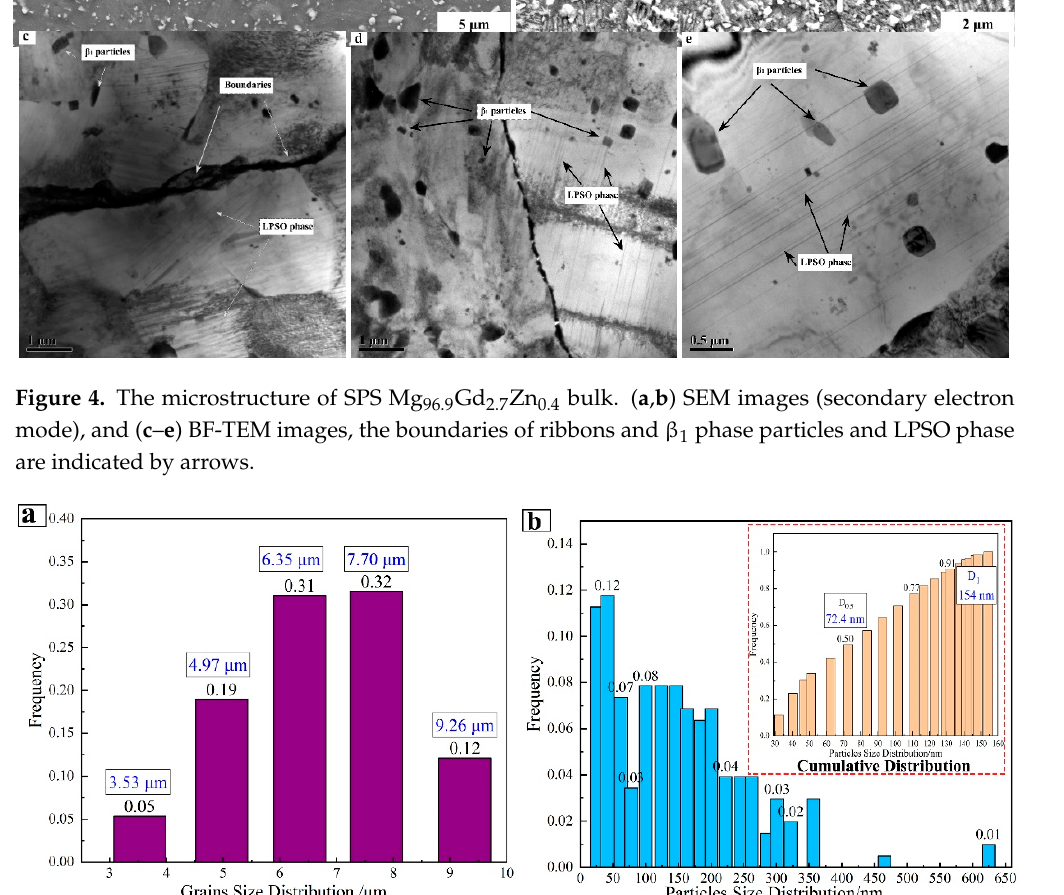
Figure 5. Phase size distribution in the SPS alloy. ( a ) The grain size of the sintering alloy, and ( b ) β 1 phase particle size distributions, the insert is the cumulative distribution, D 0.5 is the particle size when the frequency is equal to 0.5, D 1 is the mean size.